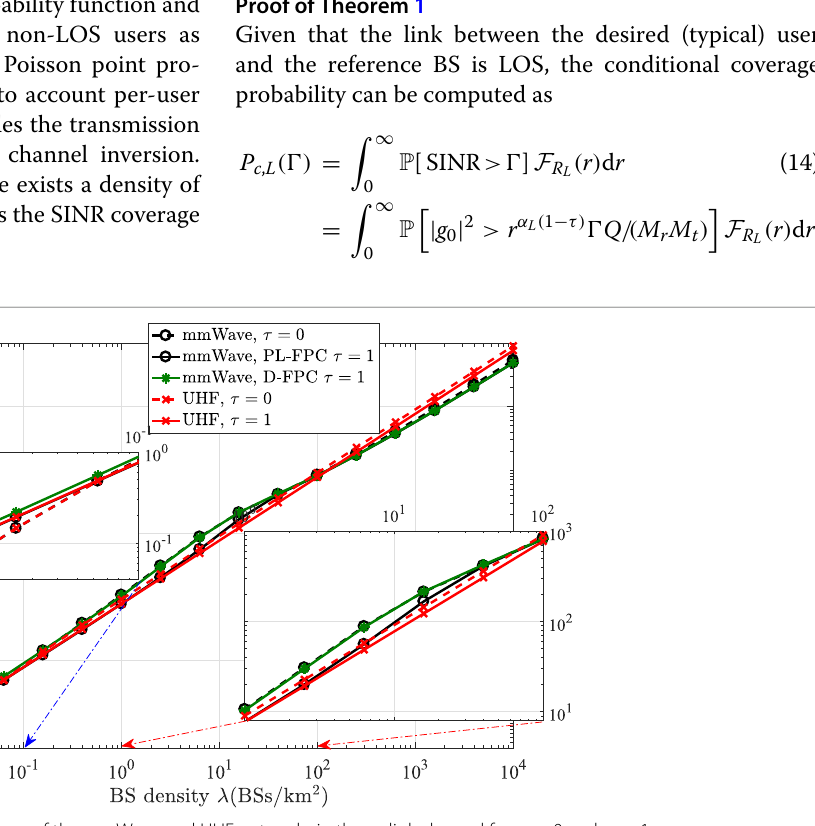
Fig. 12 Comparison of the area spectral efficiency of the mmWave and UHF networks in the uplink channel for τ = 0 and τ =